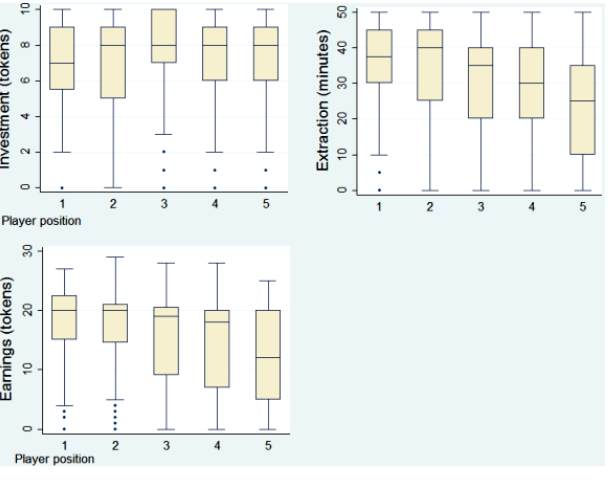
Fig. 5. Average investments, appropriations, and earnings during the baseline phase by player